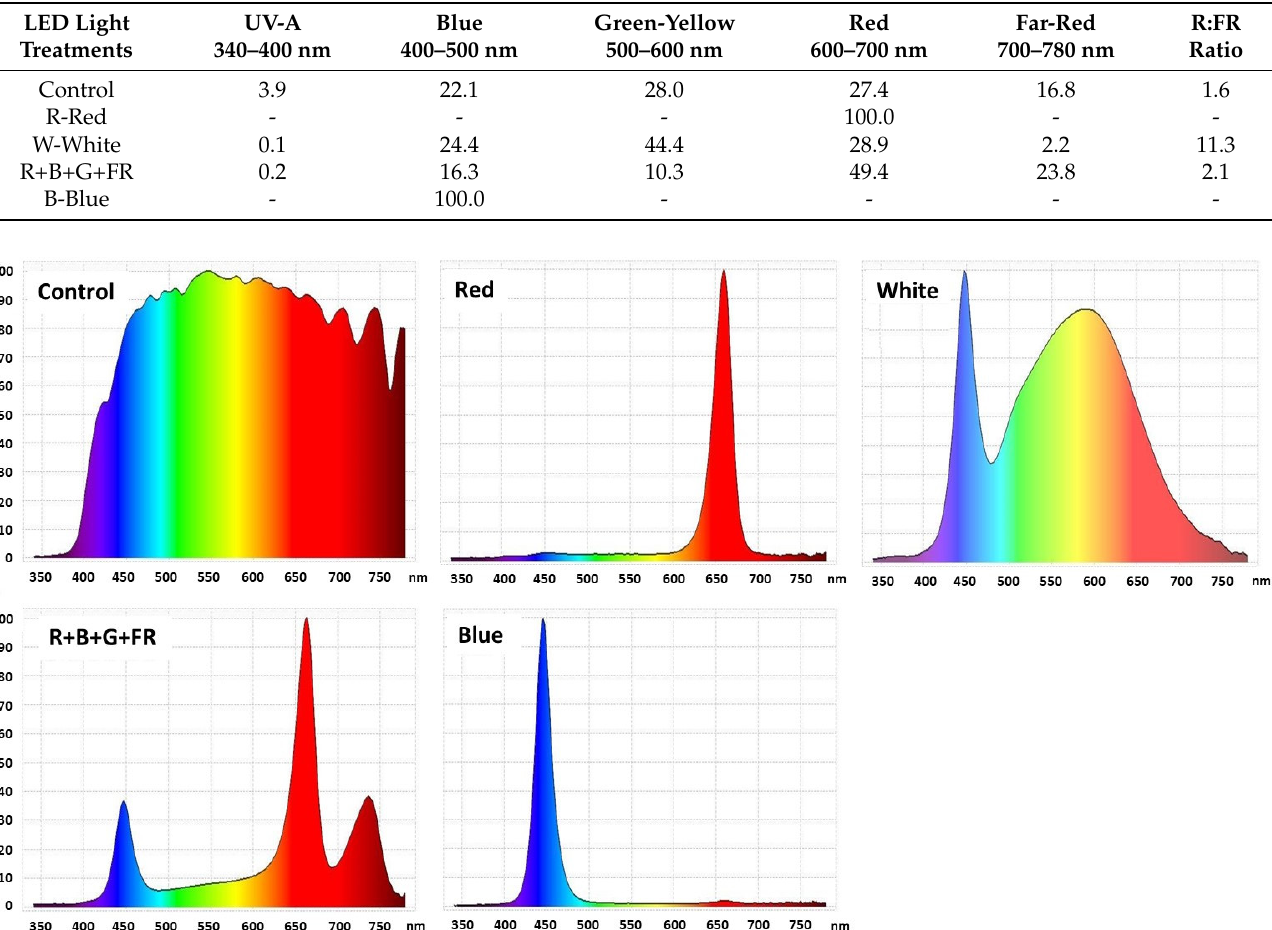
Table 2. The percentage share of individual colours in light-emitting diodes LED light treatments and control (natural sunlight in a greenhouse). The fraction of the integral photon flux ranged from 340 to 780 nm in ultraviolet, blue, green-yellow, red, and far-red). Spectra were recorded and averaged at six locations.